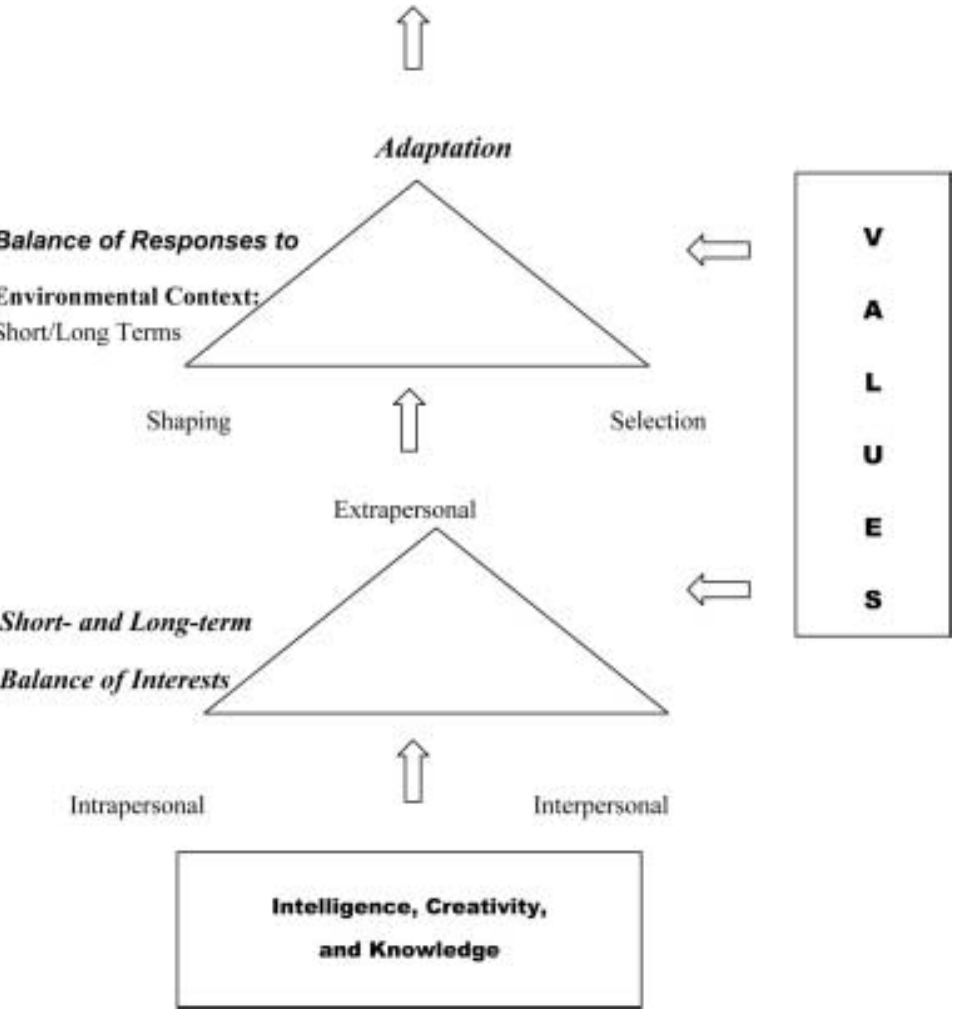
Figure 1. The structure of